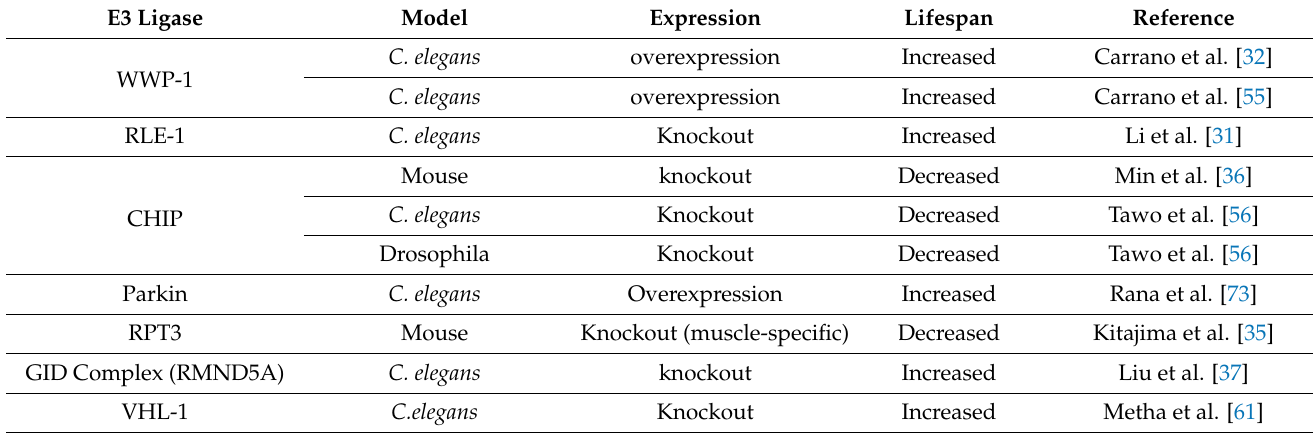
Table 1. Summary of E3 ubiquitin ligases identified in the regulation of